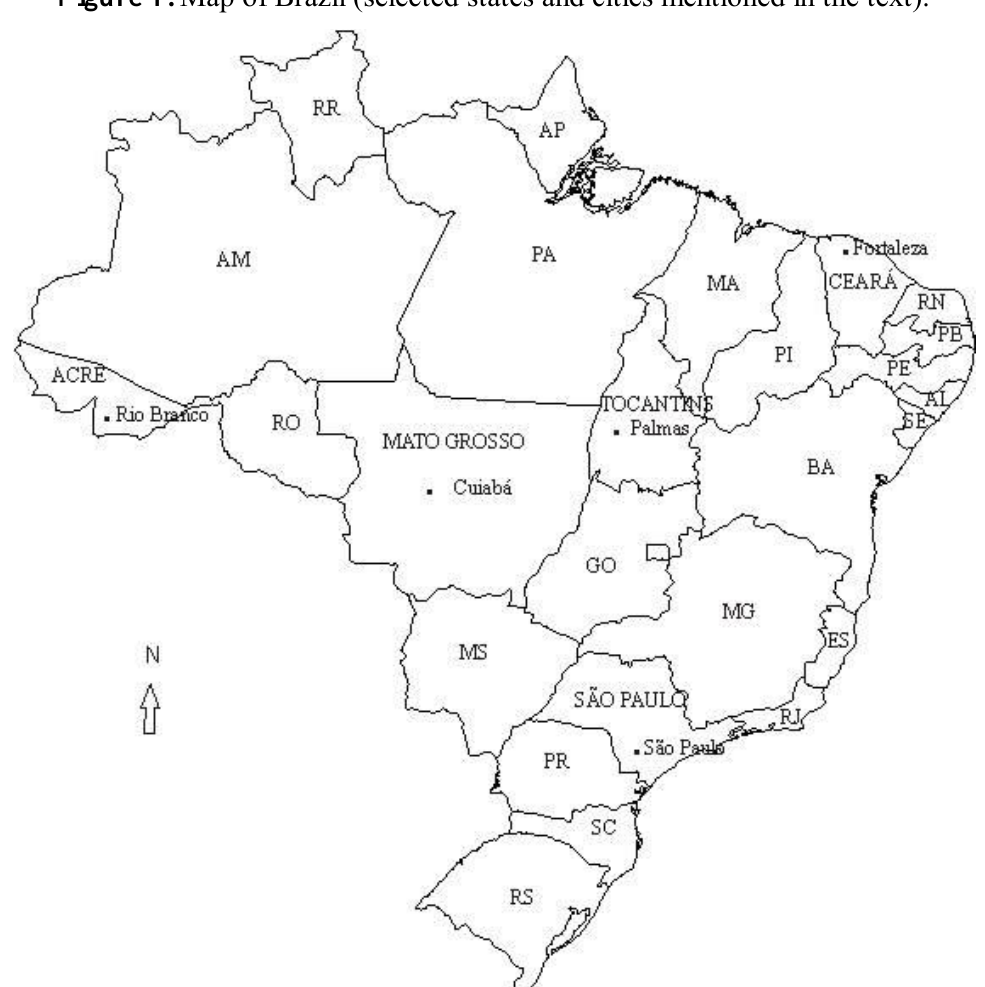
Figure 1. Map of Brazil (selected states and cities mentioned in the